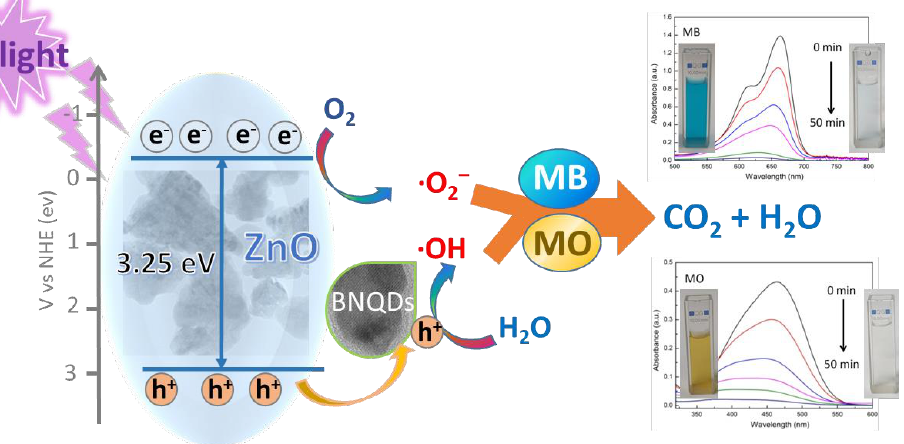
Figure 9. Schematic of the possible photocatalytic mechanism of ZnO/BNQD nanocomposites for MB and MO degradation.